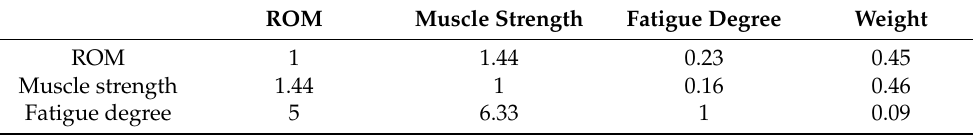
Table 5. The comprehensive assessment weight judgement matrix.